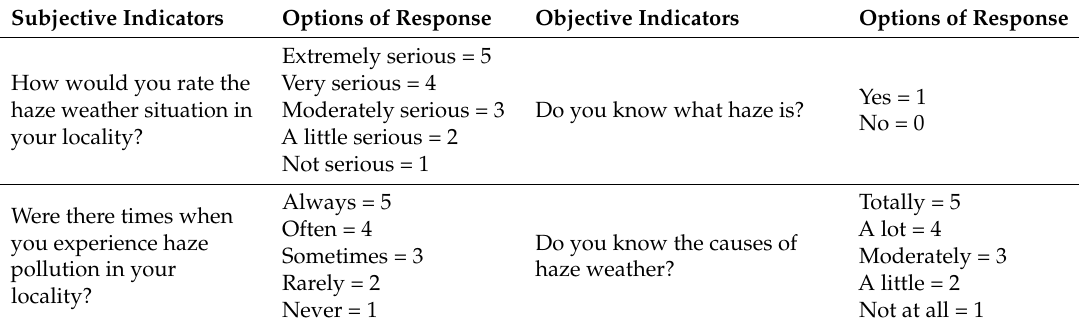
Table 2. Environmental awareness indicators.